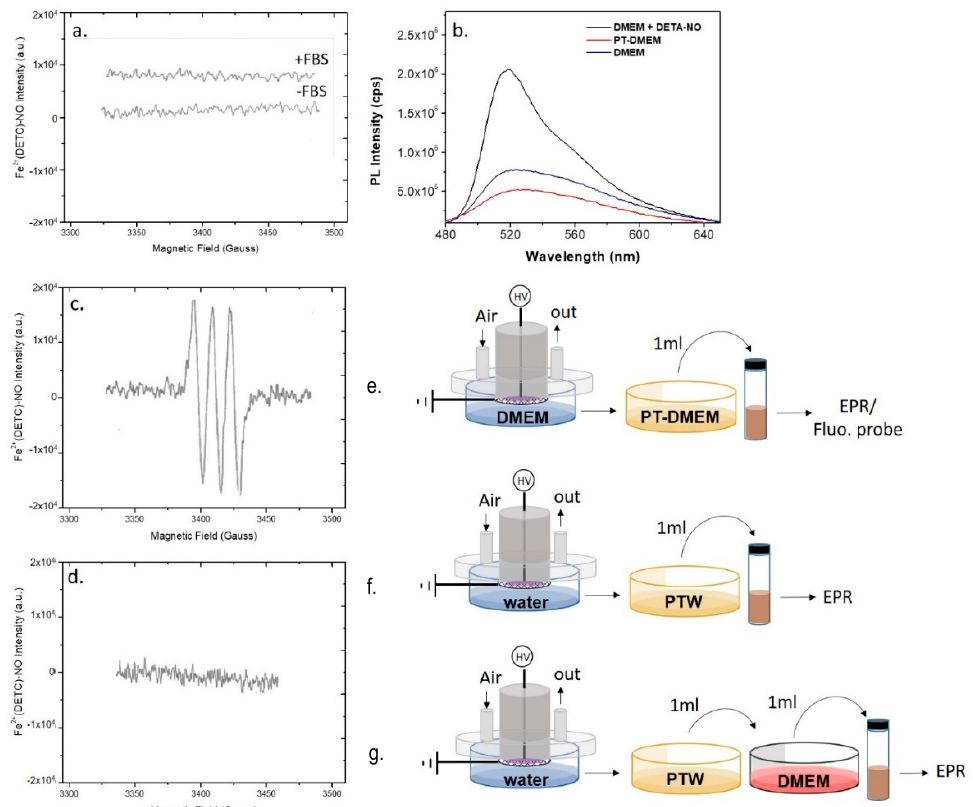
g.e. f. Figure 4. Plasma synthesis of • NO in ddH 2 O and DMEM. EPR spectra of ( a , e ) PT-DMEM with (+FBS) and without (-FBS) Fetal Bovin Serum (FBS), ( c , f ) PTW, and ( d , g ) PTW mixed with 1 mL of untreated DMEM. ( b,e ) Fluorescent spectra of PT-DMEM, DMEM with the addition of the • NO donor DETA-NONOate (100 µ M) and untreated DMEM (NT-DMEM) after the use of the fluorescent probe DAF-FM excited at 450 nm All measurements were acquired 15 min after the DBD. Experimental conditions: 15 min, 0.5 slm Air, 13 kV, 6 kHz, 50% DC, 100 ms period. Schemes of the experimental procedures used for the EPR are reported on the right of each spectrum.